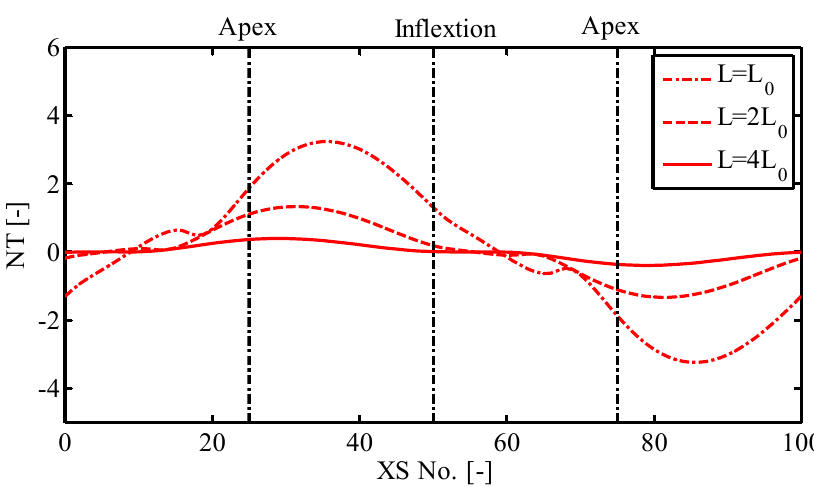
Figure 6. Sensitivity analysis of NT magnitude on the meander wavelength L . NT = the difference between the magnitudes of the RHS terms of Equations (16) and (17); XS No. = cross ‐ section number in the model. The channel starts and ends at the inflexion. L 0 = characteristic channel length, equivalent to the channel length in Friedkin’s experiment when θ 0 = 90° (15.062 m).